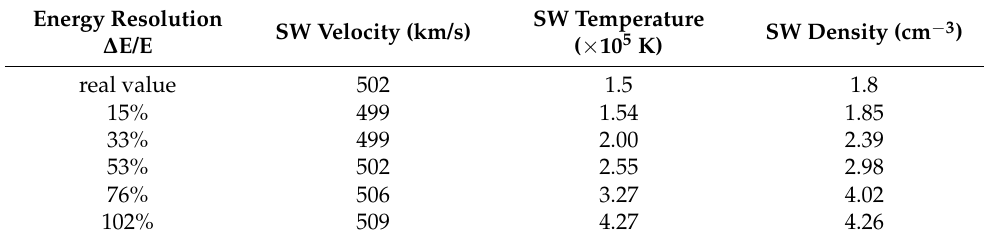
Table 4. Inversed SW parameters under different energy